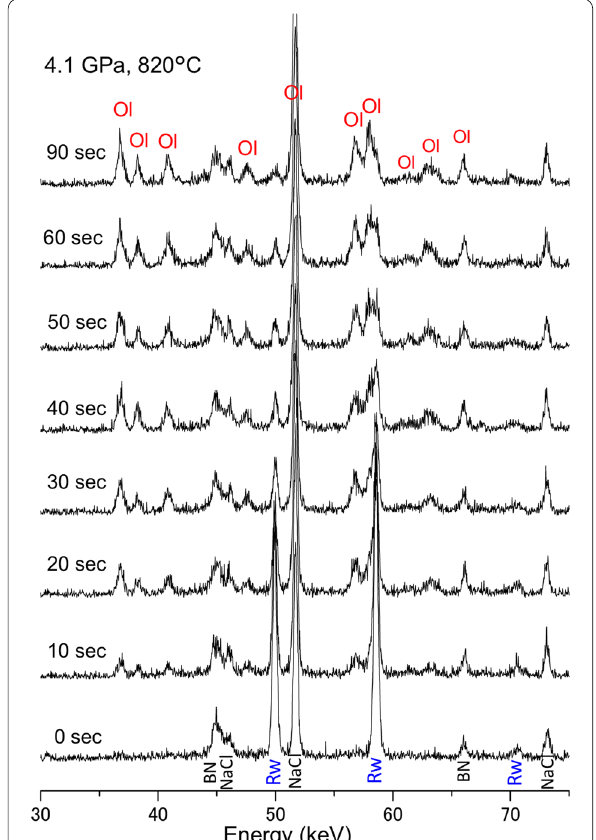
Fig. 3 Changes of XRD patterns during the back-transformation in ringwoodite. Ringwoodite (Rw) directly transforms to olivine (Ol) at 4.1 GPa and 820 °C (Run